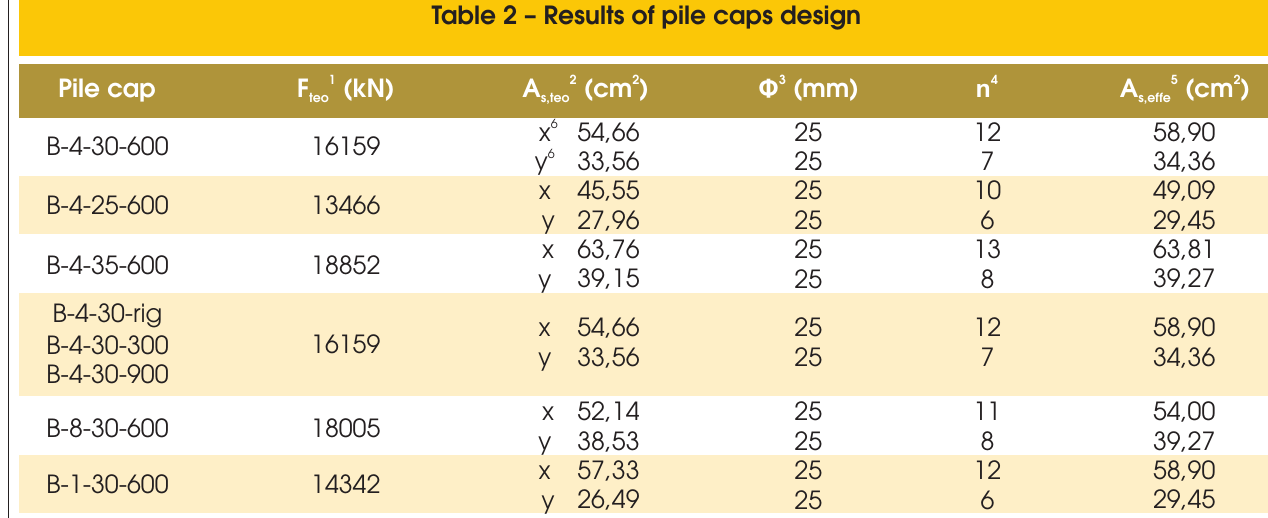
Table 2 – Results of pile caps